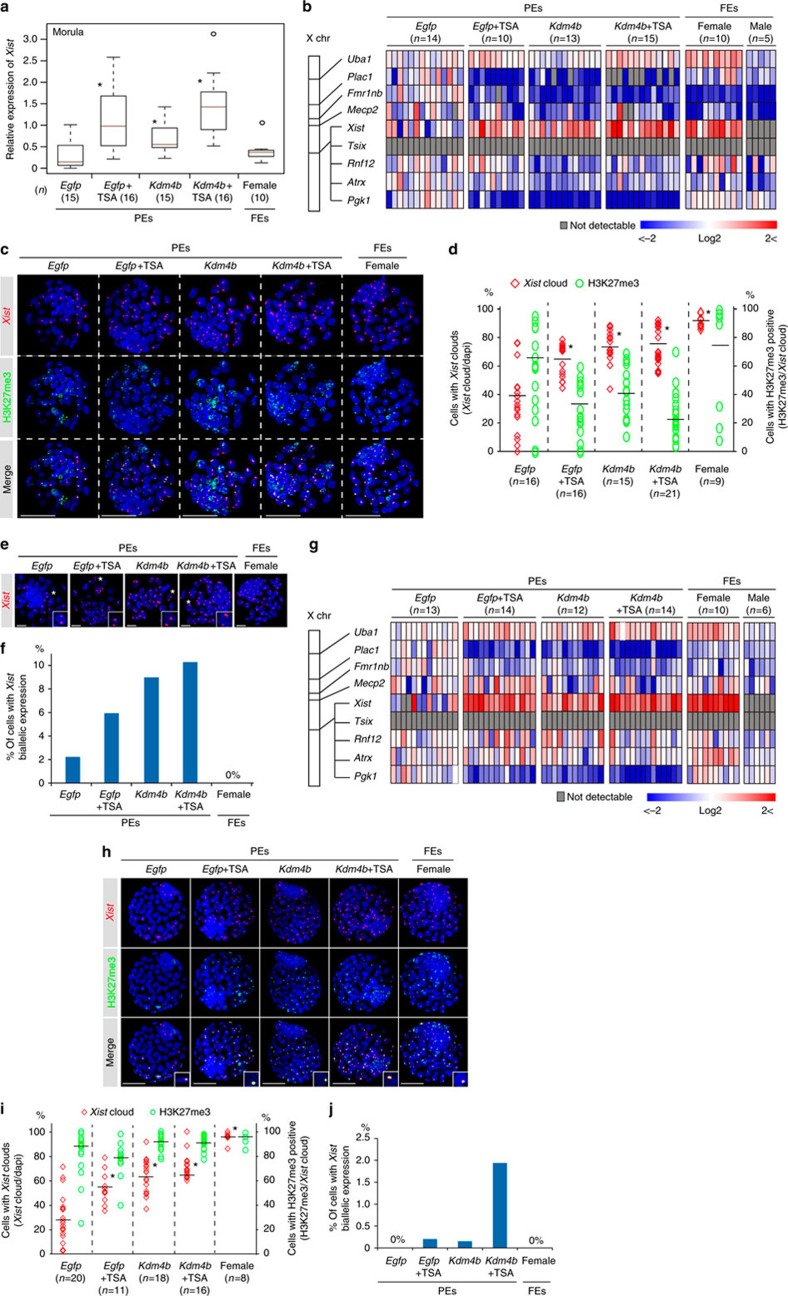
Global XCI and Xist expression states of Xm at late preimplantation stages.(a) Analysis of Xist expression using qPCR of individual embryos in the morula. An asterisk indicates P<0.05 (Student’s t-test) compared with Egfp-PEs. FEs, fertilized embryos. (b) Large-scale qPCR analysis of Xist and eight X-linked genes in individual blastocysts after culturing for 96 h. Coloured bars indicate expression levels. (c,d) IF (H3K27me3, green) combined with RNA FISH (Xist, red) analysis in 96-h blastocyst stage. 4′,6-diamidino-2-phenylindole (DAPI)-stained nuclei are shown in blue. (c) Representative confocal projection. Scale bars, 50 μm. (d) The graph shows Xist expression and H3K27me3 modification states in individual embryos. The horizontal axis indicates the average percentage in the group. *P<3.1 × 10−28 (Fisher’s exact test). n, number of embryos analysed. (e,f) Xm-Xist biallelic expression states in PEs at 96 h. The asterisk indicates cells with biallelic expression. Scale bars, 20 μm. (f) Summary of the ratio of biallelic cells to Xist-positive cells in 96-h blastocyst stage in each group. The number of cells is shown in Supplementary Table 3. (g) qPCR analysis of Xist and eight X-linked genes in individual blastocysts after culturing for 120 h. (h,i) IF (H3K27me3, green) combined with RNA FISH (Xist, red) analysis in 120 h blastocysts. *P<5.4 × 10−23 (Fisher’s exact test). Scale bars, 50 μm. (j) The ratio of biallelic cells to Xist-positive cells in 120 h blastocysts. In qPCR analysis, the average expression level of Xm-Xist in Egfp-PEs was set as 1 (also see the Methods section). Gapdh and β-actin were used as internal controls. Data are summarized in Supplementary Table 4.